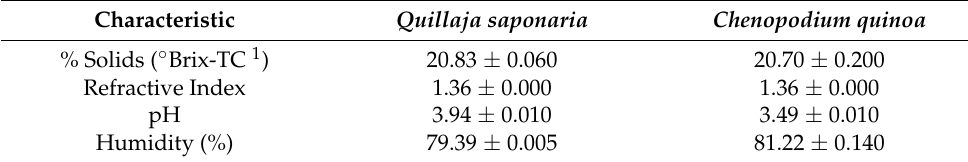
Table 1. Characteristics of Quillaja saponaria and Chenopodium quinoa extracts. Characteristic